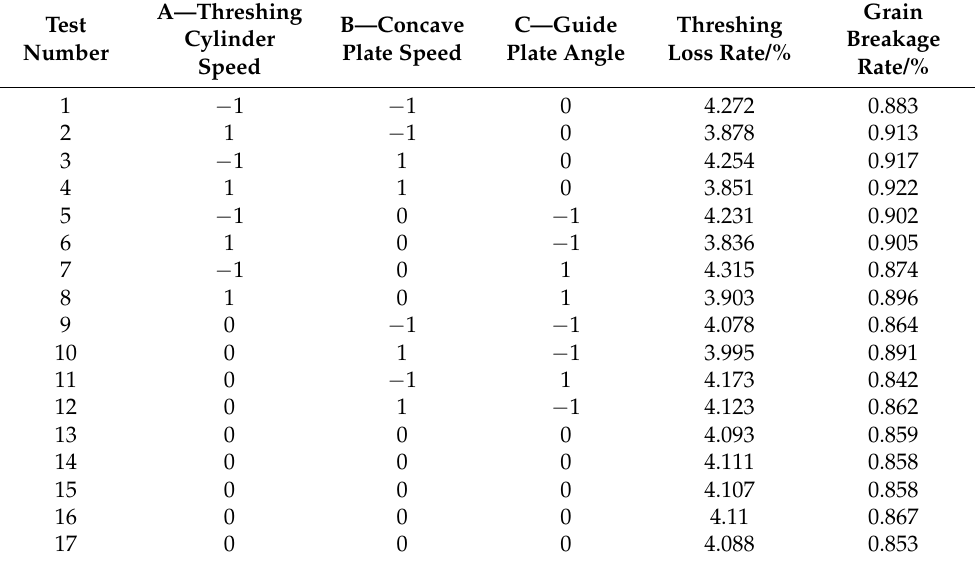
Table 8. The oilseed rape threshing test results.